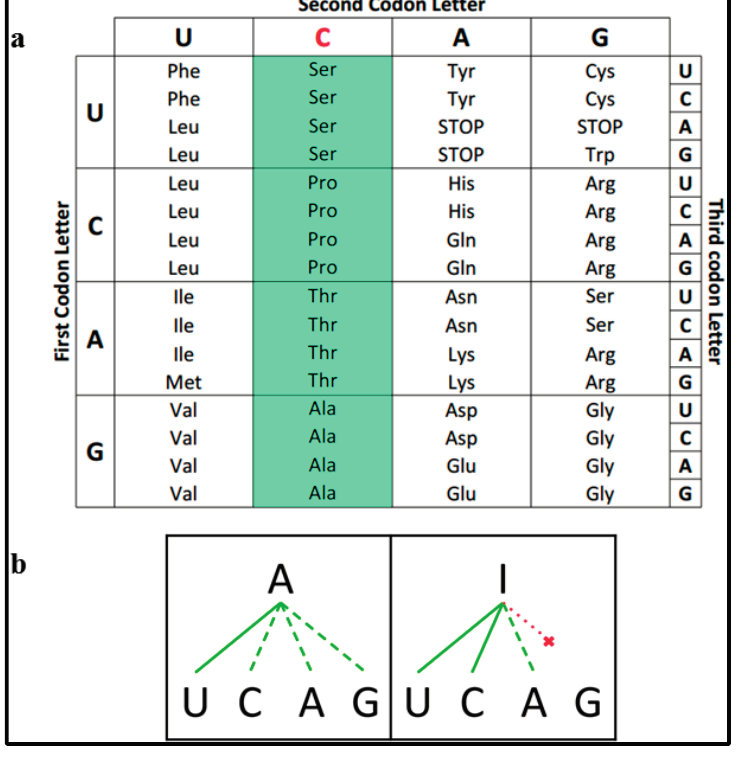
Figure 5. ( a ) Codon usage table. Highlighted in green are all the codons that translate for TAPS that share a common C in their second position (red); ( b ) Schematic representation of base pairing between Adenine (or Inosine) and the rest of the classical bases. Continuous green lines indicate preferred pairings and dashed green lines indicate poor pairings. Dashed red line indicates no